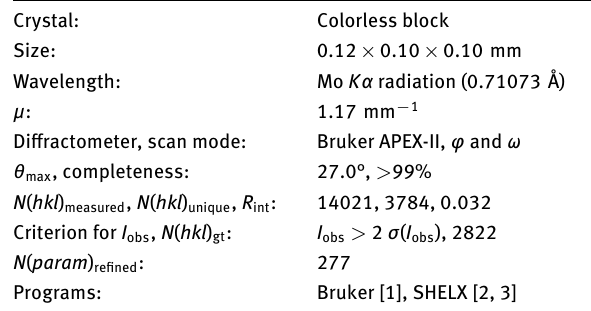
Table 1: Data collection and